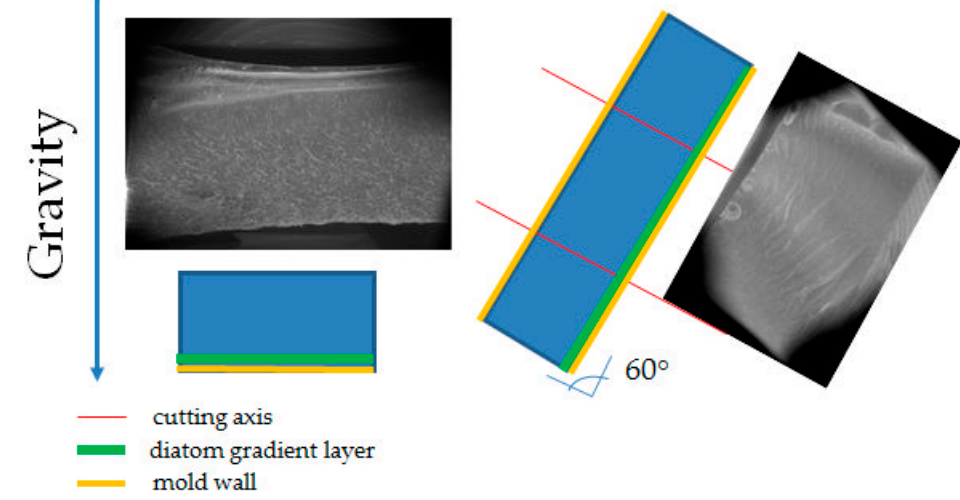
Figure 1. A glass mould, a silicone mould, inclination, and sedimentation direction of diatomaceous earth.